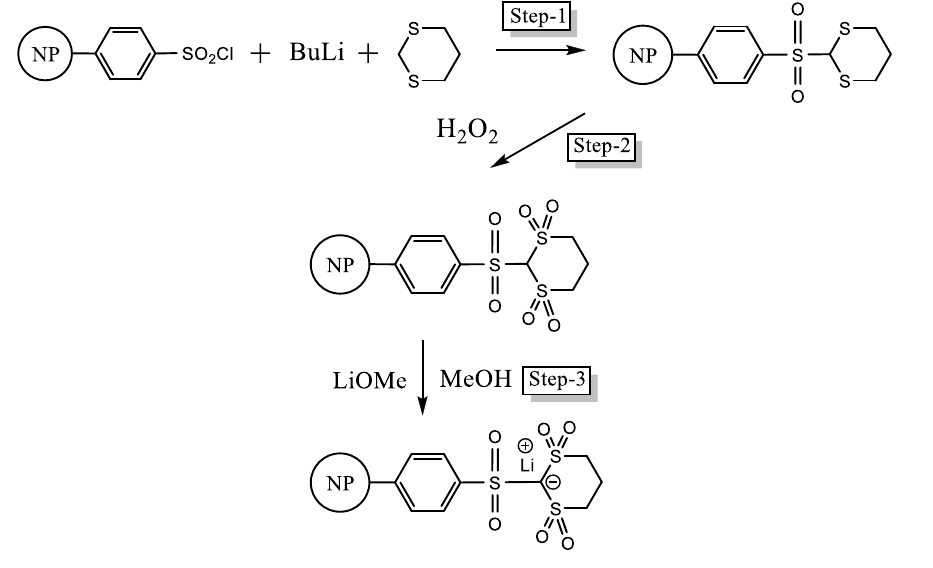
Figure 3. Synthesis of PSDTTOLi.